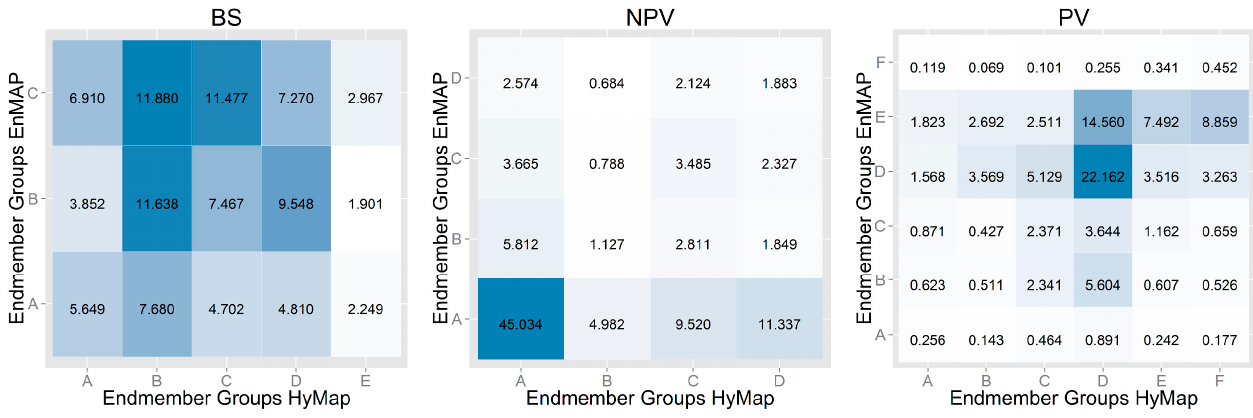
Figure 8. Endmember sub class confusion matrix for BS, NPV and PV between EnMAP and HyMap imagery. Values given as percentage of